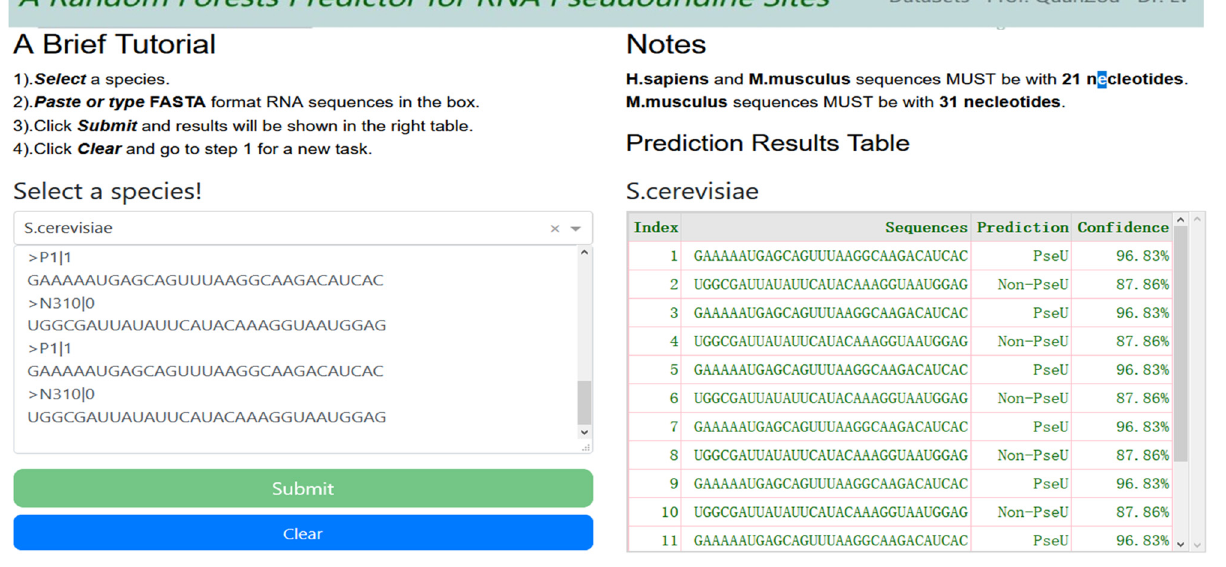
Frontiers in Bioengineering and Biotechnology |